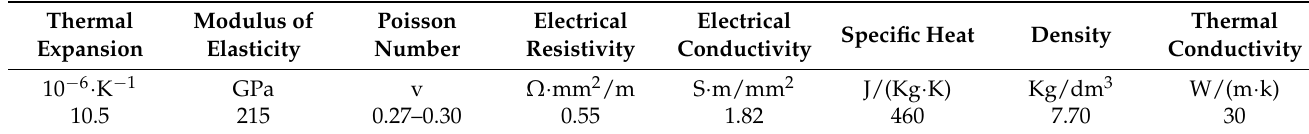
Table 2. The physical properties of X39Cr13 stainless steel.